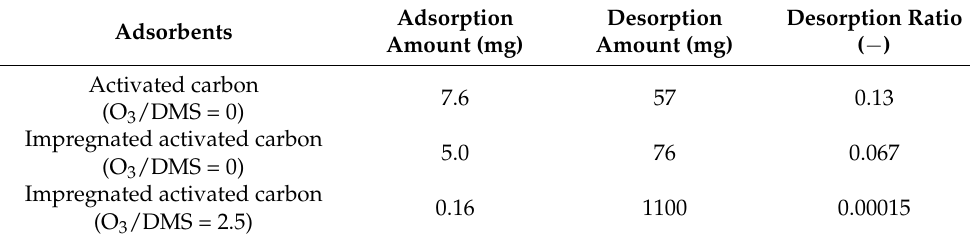
Table 6. Desorption ratio of each